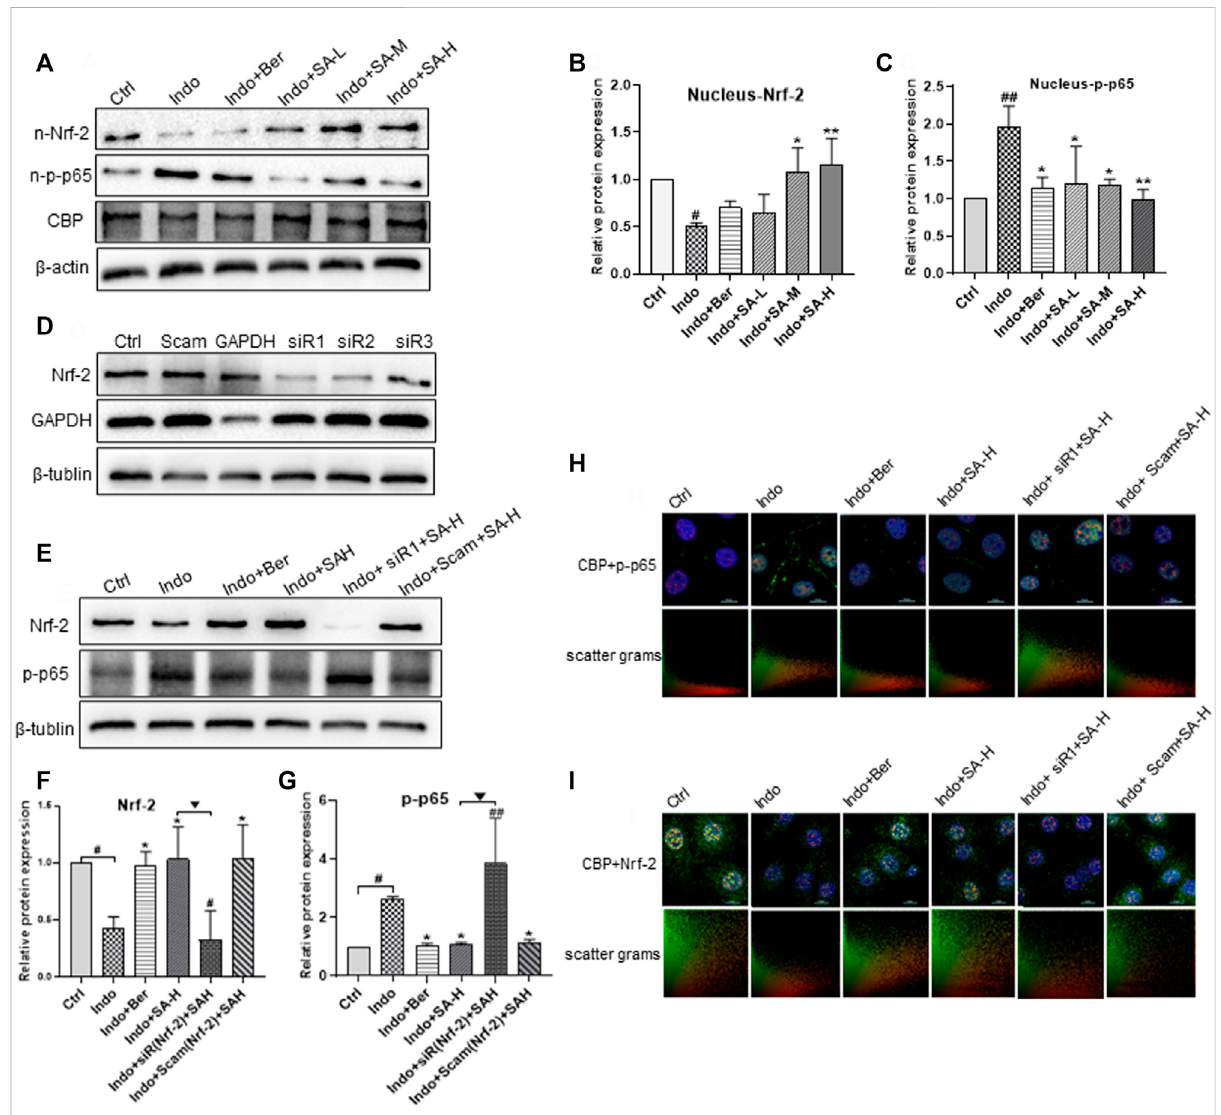
FIGURE 8 RegulationofSAonendonuclearexpressionandco-localizationofNrf2,p-p65andCBPinIEC-6andtheeffectofNrf2interference.IEC-6cells weretreatedwithindomethacin(Indo,300 μ mol L − 1 )and/orsanguinarine(SA,0.25,0.5,and1.0 μ mol L − 1 ,SA-L,SA-MandSA-H,respectively)orwith berberine (Ber, 30 mmol L − 1 ). (A – C) Effects of SA on the expression of NRF-2, p-p65 and CBP in IEC-6. (D) Effects of different Nrf2 siRNAs on the Nrf2 levels of IEC-6 cells. IEC-6 cells were treated with 3 different Nrf2 siRNAs (50 nM), scrambled duplex (a blank control) or GAPDH siRNA (a positive control of RNA silencing). The expression of Nrf2 and GAPDH was measured by Western blot. (E – G) Effects of Nrf2 siRNA on the Nrf2 levels of IEC-6 cells at the present of indomethacin. (H,I) Effect of Nrf2 siRNA on location of Nrf2 and p-p65 in IEC-6 cells shown by laser confocal immuno fl uorescence staining. Nrf2 and p-p65 were labeled with green and red FITC, respectively. Nuclei were stained with DAPI. The upper right corneroftheMergediagramisthescatterplotsofNrf2(green)andp-p65(red),withtheordinateofNrf2andtheabscisofp-p65.Dataarepresented as the mean ± SD ( n = 3). # p < 0.05 and ## p < 0.01 vs. control (Ctrl). * p < 0.05 and ** p < 0.01 vs. indomethacin (Indo). ▼ p < 0.05 and ▼▼ p < 0.01 vs.